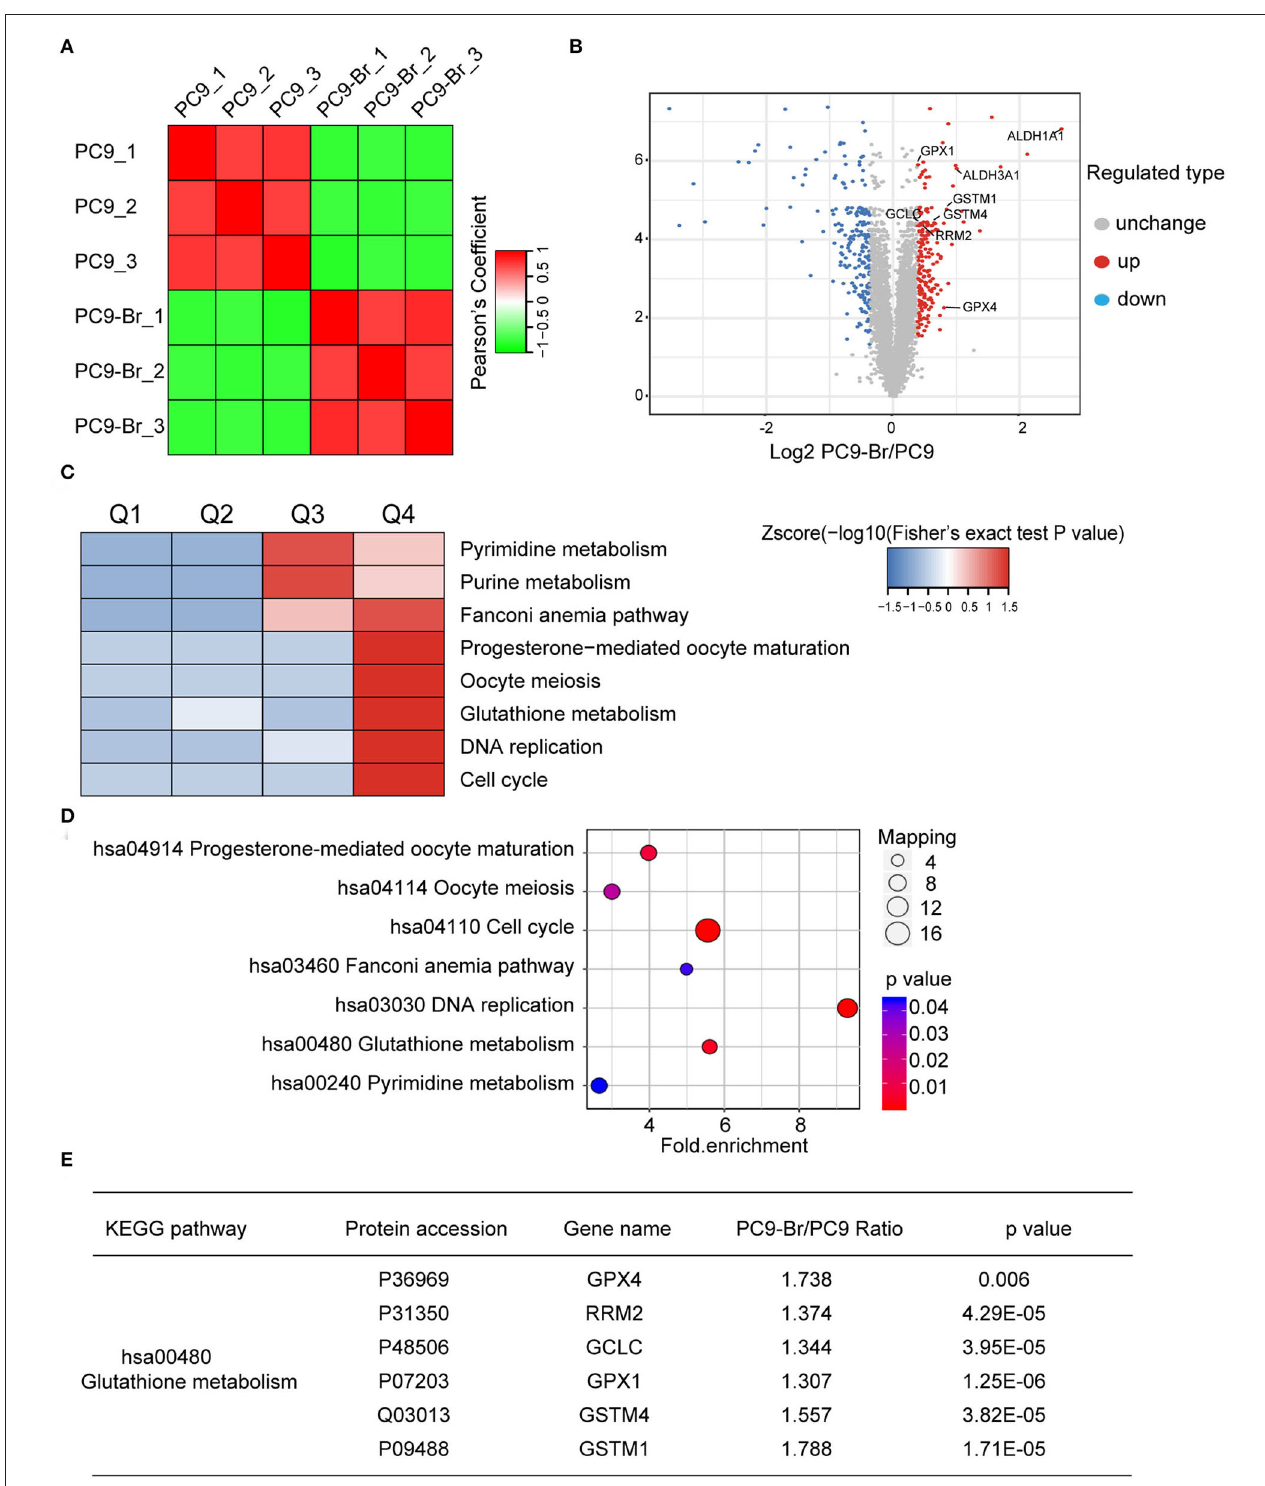
FIGURE 3 | Proteomics identified the hyperactive GSH metabolism pathway in PC9-Br cells. (A) Correlation analysis for reproducibility of proteomics data. (B) Volcano plot showed the distribution of differential proteins in Q4 group (ratio fold > 1.3). The horizontal axis is Log2 transformed protein expression ratio, and the vertical axis is –Log10 transformed p- value. Red dot: up-regulated protein; blue dot: down-regulated protein. (C) Functional KEGG enrichment cluster image showing the common enriched pathways in PC9-Br cells. (D) Results of KEGG enrichment analysis of differential proteins in groups (PC9-Br/PC9) visualized in bubble diagram (including the number of respective involved proteins and the corresponding p -values). (E) The specific differential proteins identified in groups (PC9-Br/PC9) involved in GSH metabolism pathway are listed.